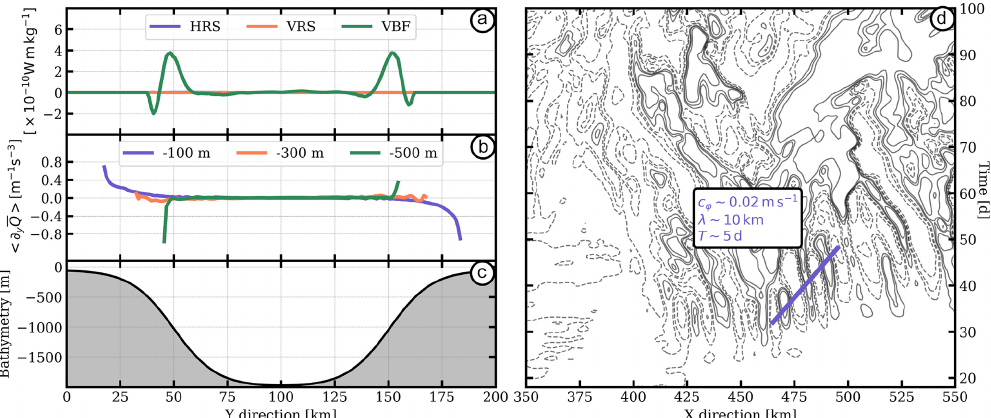
Figure 5. Diagnostics computed from NO-BBL. (a) Energy conversion terms: (blue) HRS, (orange) VRS and (green) VBF vertically inte- grated between 150 and 1000m depth. (b) Timely and zonally averaged meridional PV gradient computed at (blue) 100, (orange) 300 and (green) 500m depth. (c) Bathymetry. (d) Hovmöller diagram of potential vorticity anomaly at 500m depth and y ∼ 40km.